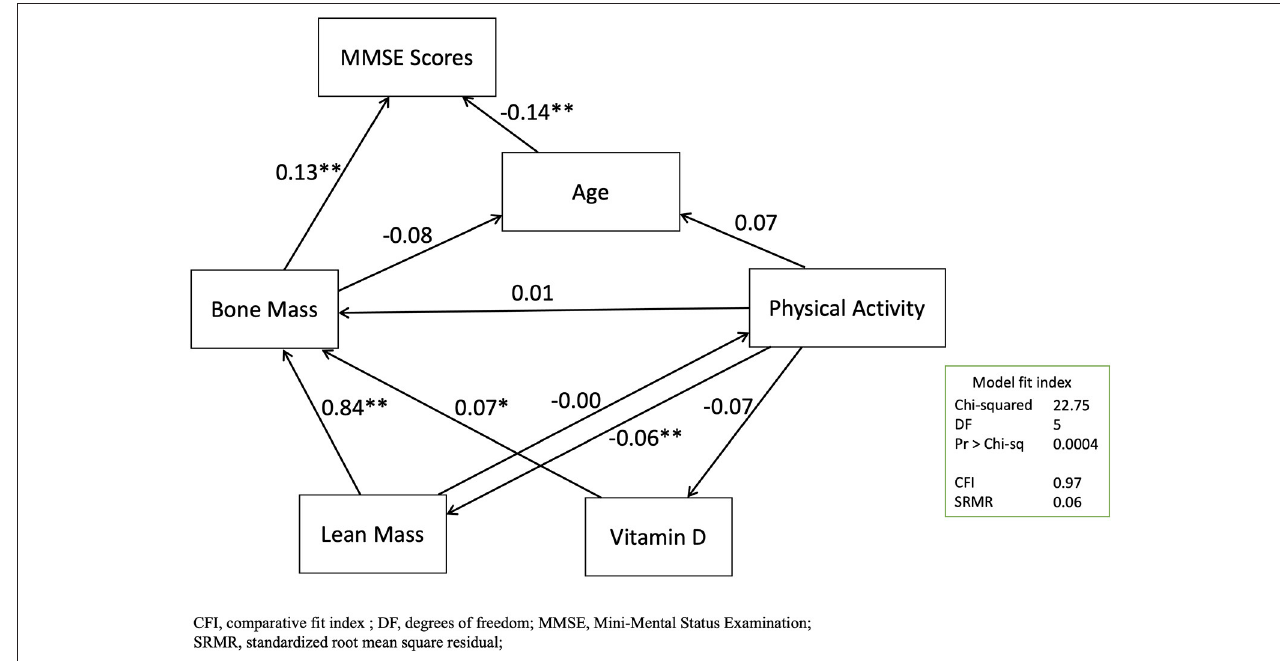
FIGURE 3 | Graphical presentation of the structural equation modeling. * p < 0.05, ** p < 0.01.